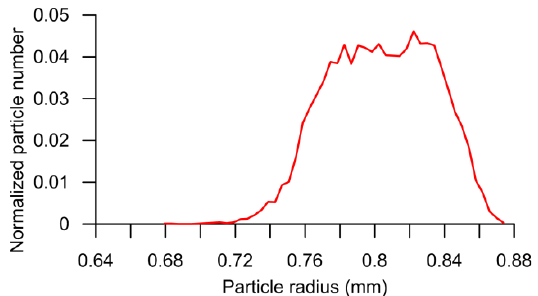
Fig. 2. Simulated distribution of electrons over radius in slow-wave structure